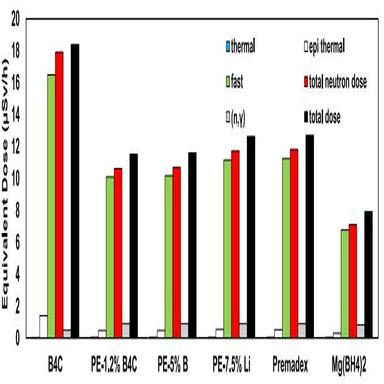
Comparison of B4C and advanced neutron shield materials.